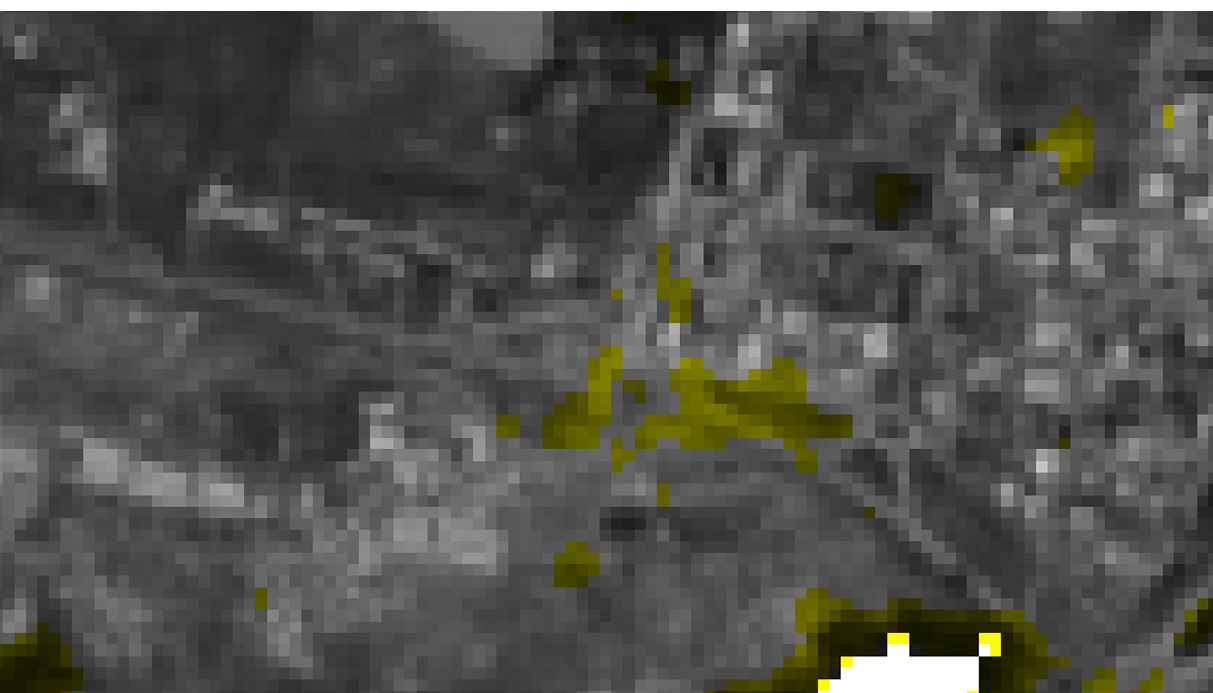
Figure 5. Landsat Image of Castello road on June 10, 2016 with areas of ’significant’ pixel value change highlighted. Signif- icant pixel change detection algorithm developed by Jamon Van Den Hoek.